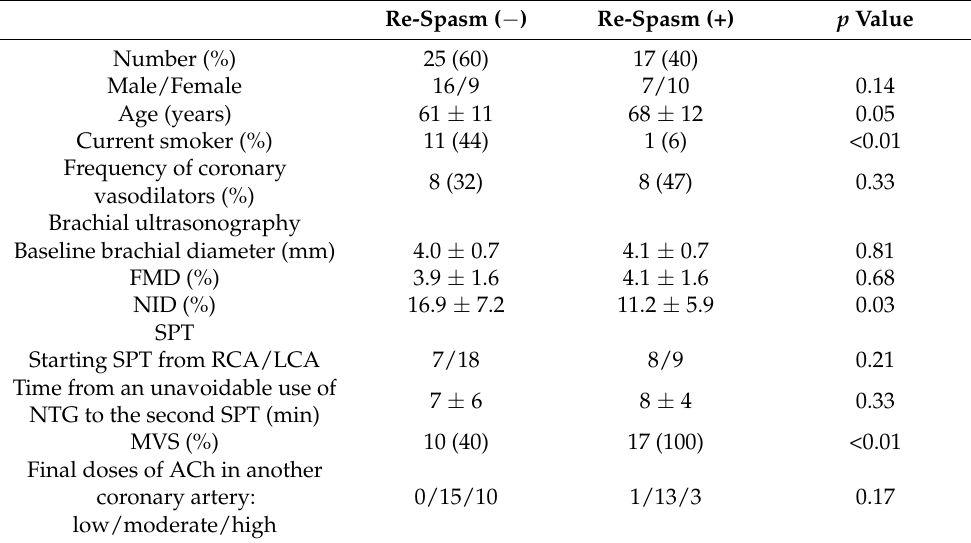
Table 5. Results of a second SPT in another coronary